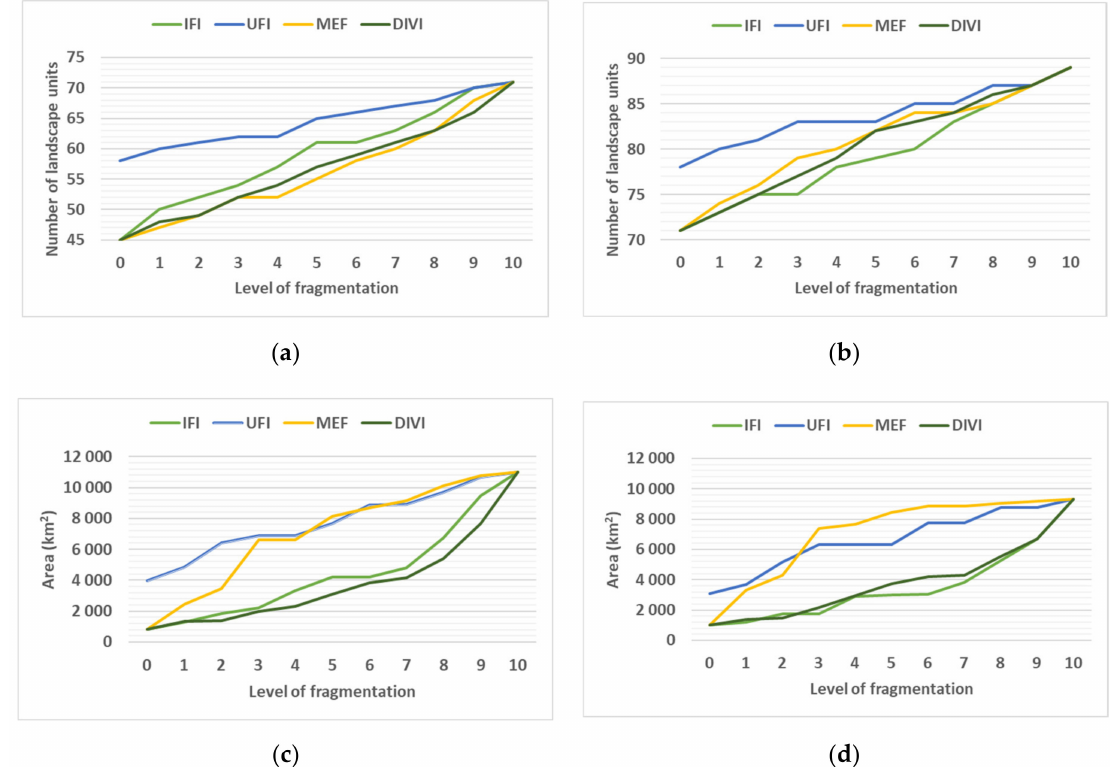
Figure 9. Cumulative representation of total number of LU and total LU surface area ordered from 0 (not fragmented) and 1 to 10 from lowest to highest level of fragmentation: SPAs ( a , c ) and SACs ( b , d